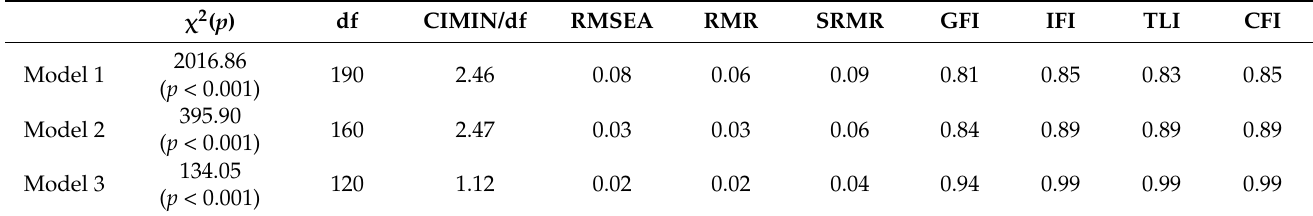
Table 4. Analysis of construction